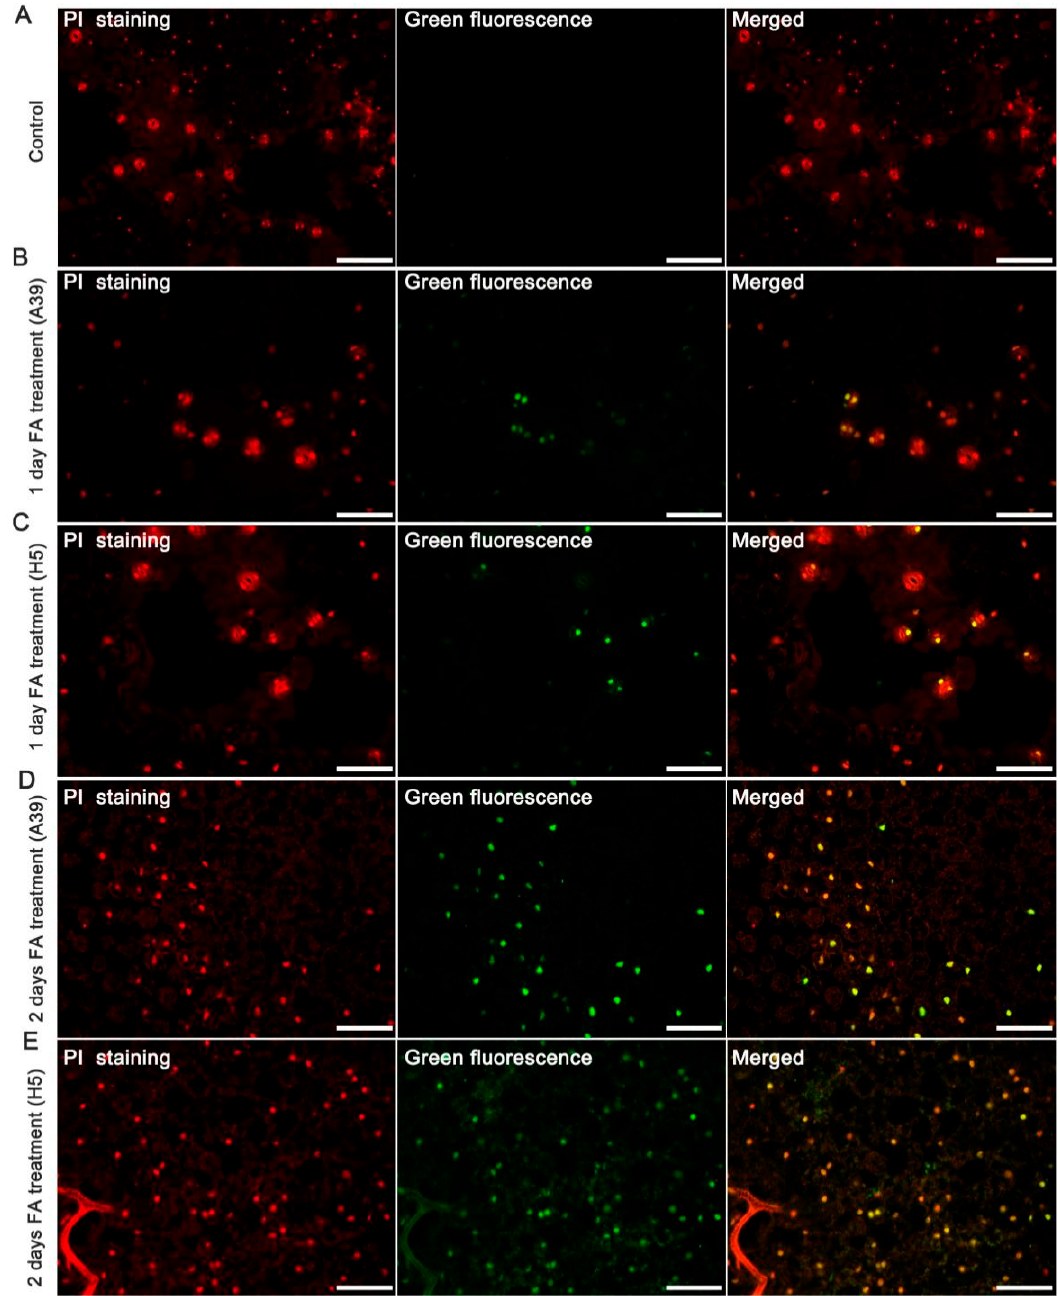
Figure 2. TUNEL assay of ‘A39’ and ‘H5’ from seedling leaves. ( A ) Apoptosis detection of the control plant under normal condition. Bars = 200 µ m. ( B ) ‘A39’ and ( C ) ‘H5’ after 1 day of FA treatment. Bars = 200 µ m. ( D ) ‘A39’ and ( E ) ‘H5’ after 2 days of FA treatment. Bars =400 µ m. The Green Fluorescence indicates the signal for apoptosis. The Merged represents the combination of PI staining and Green Fluorescence.